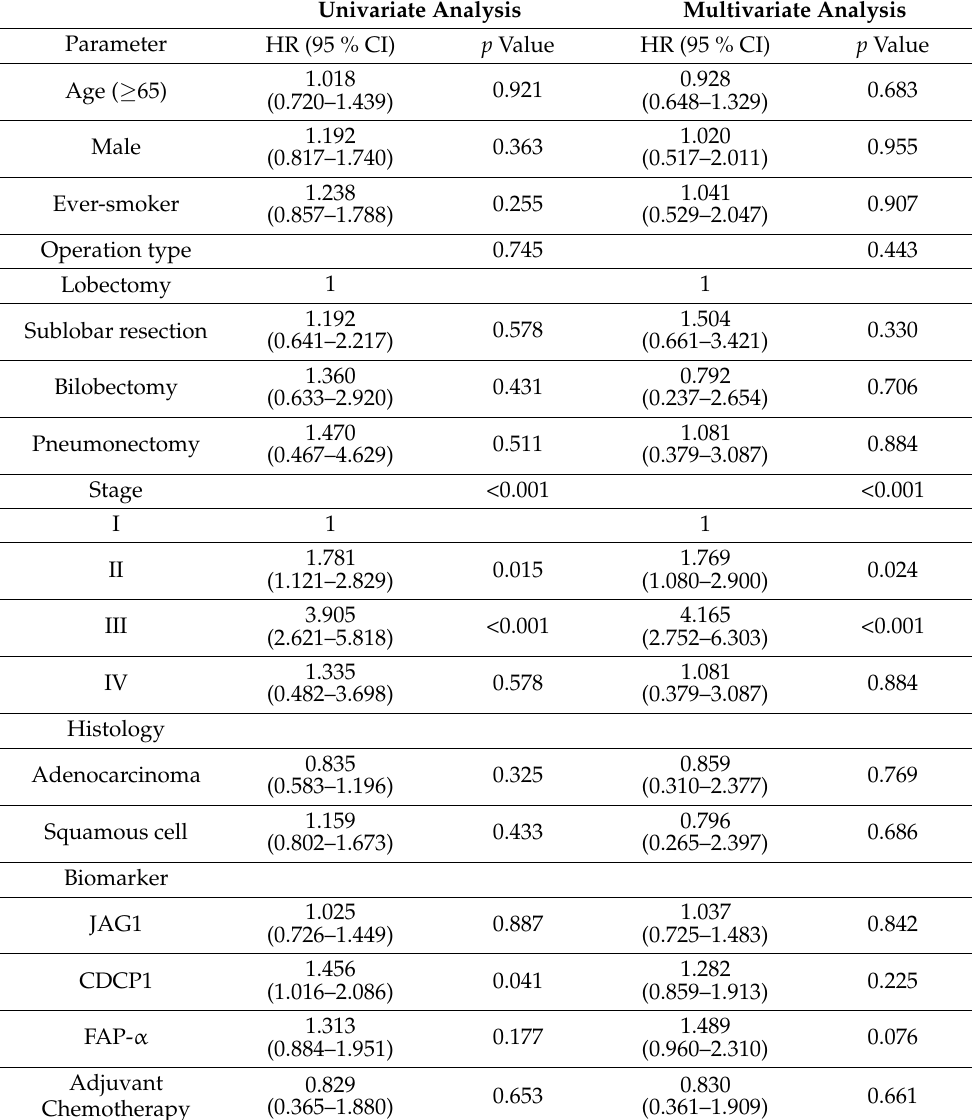
Table 2. Cox regression analysis for recurrence within 5 years after